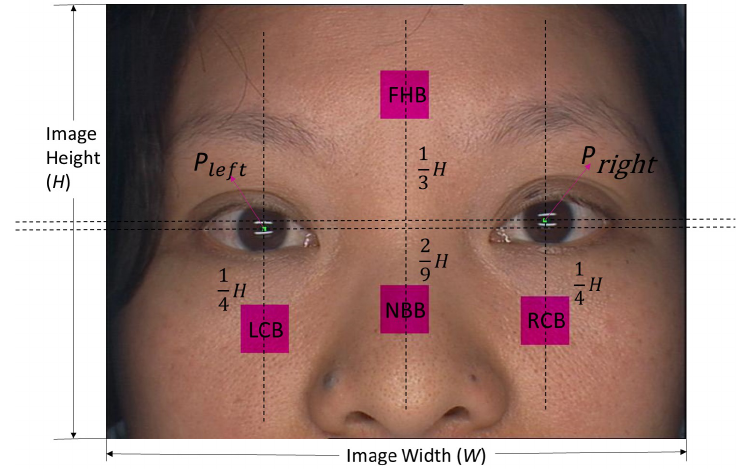
Figure 7. Four facial key block positions. The purplish pink blocks represent the four facial key blocks, where the text in the center of each block is its corresponding name. The two small green patches indicate the two pupil